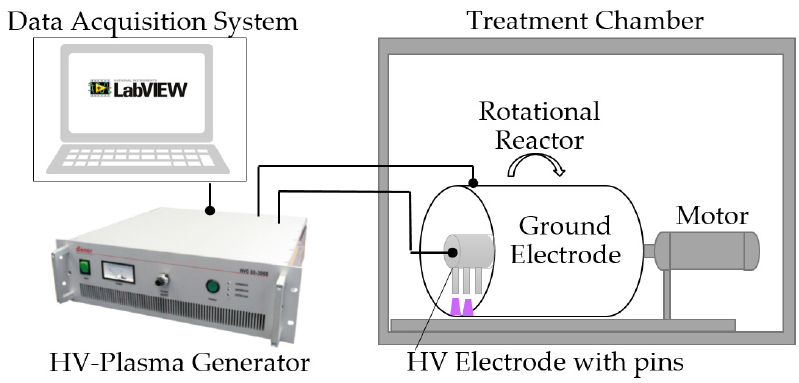
Figure 1. Experimental setup for Non-thermal plasma (NTP) treatment of wheat